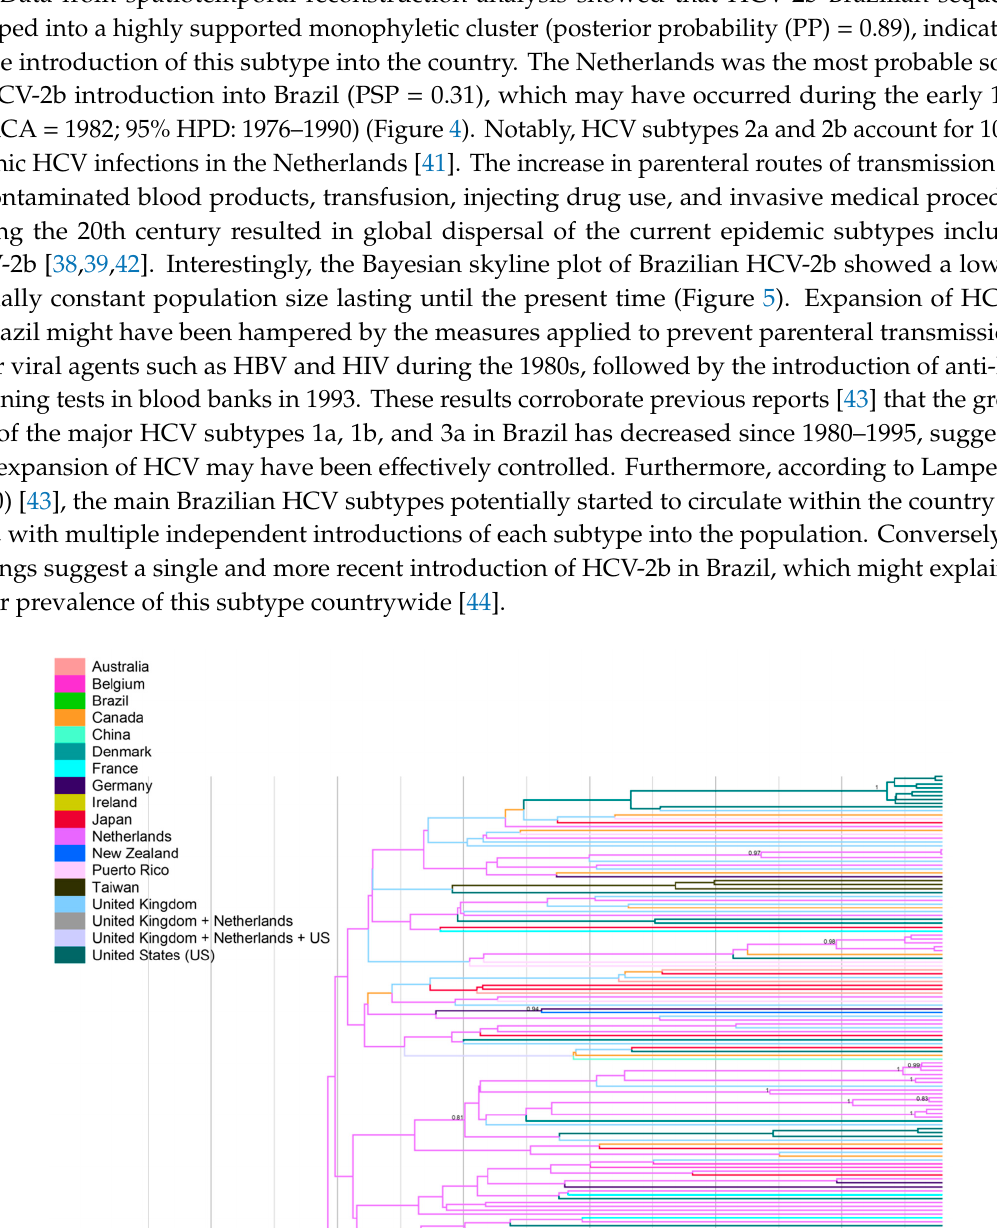
Table 2. Mean genetic distances between groups of full-length HCV subtype 2b sequences from different geographical regions.